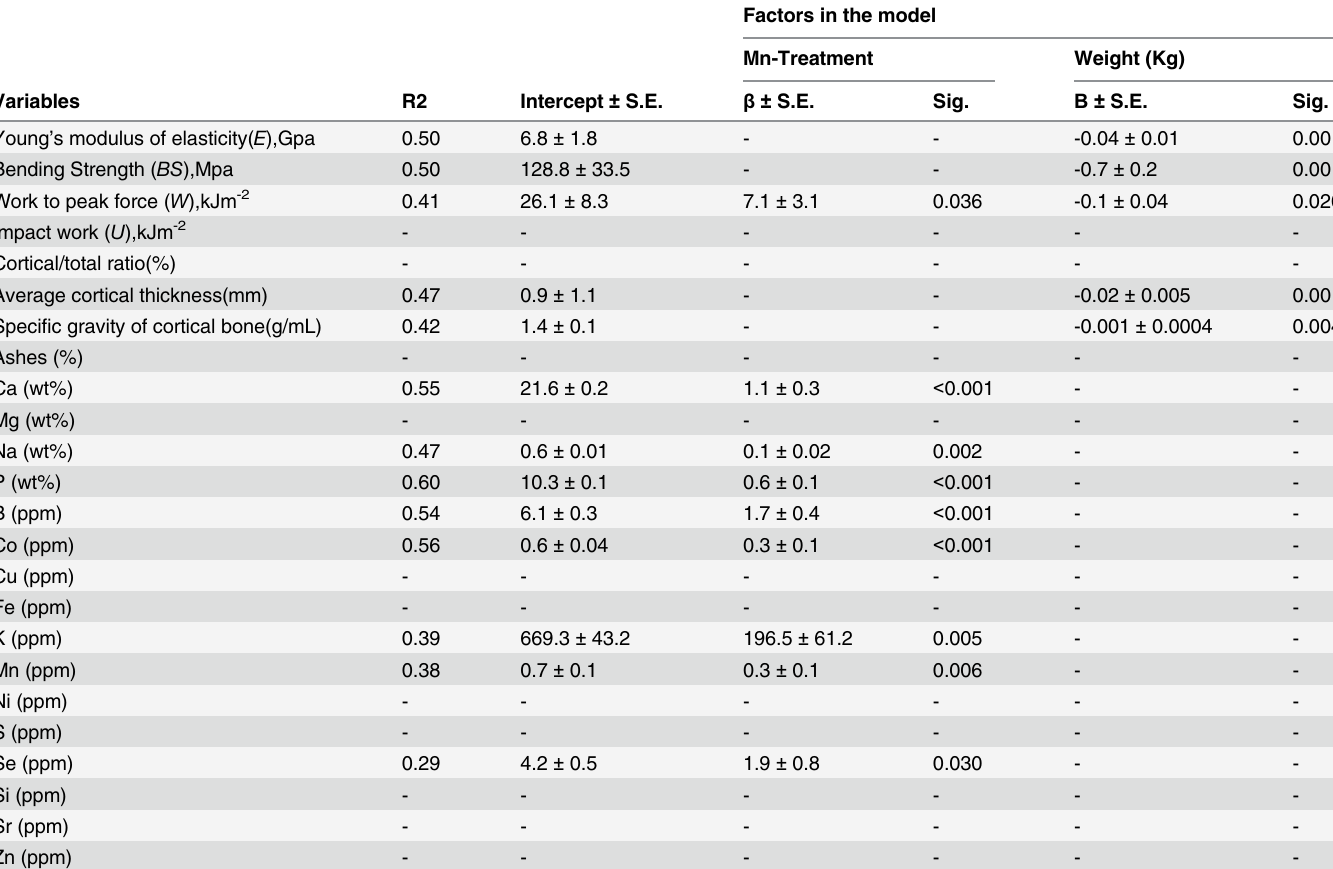
Table 4. Influence of injections of Mn (as nutrient supplement) and body weight, on the composition, structure and mechanical properties of ant- lers in the distal position (position 4), in adult red deer; the factor β is related to the difference of the value observed in animals that were injected with respect to the group not injected. Using GLMs analysis for each variable. Dashes indicate coefficients that were not